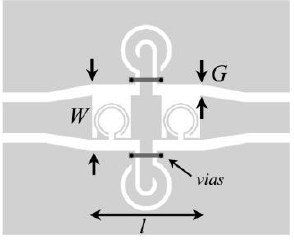
Figure 16. Topology of the unit cell of a CPW composite right/left handed transmission line based on a combination of series connected open split ring resonators in the external stages and a pair of shunt connected open complementary split ring resonators in the central stage. The considered substrate is the Rogers RO3010 with thickness h = 1.27 mm and dielectric constant  = 10.2. Dimensions are: l = 12.3 mm, W = 5 mm, G = 1.28 mm. r For the open complementary split ring resonator: r = 2.9 mm, c = 0.5 mm, d = 1.2 mm. ext For the open split ring resonators: r = 2 mm, c = d = 0.2 ex t